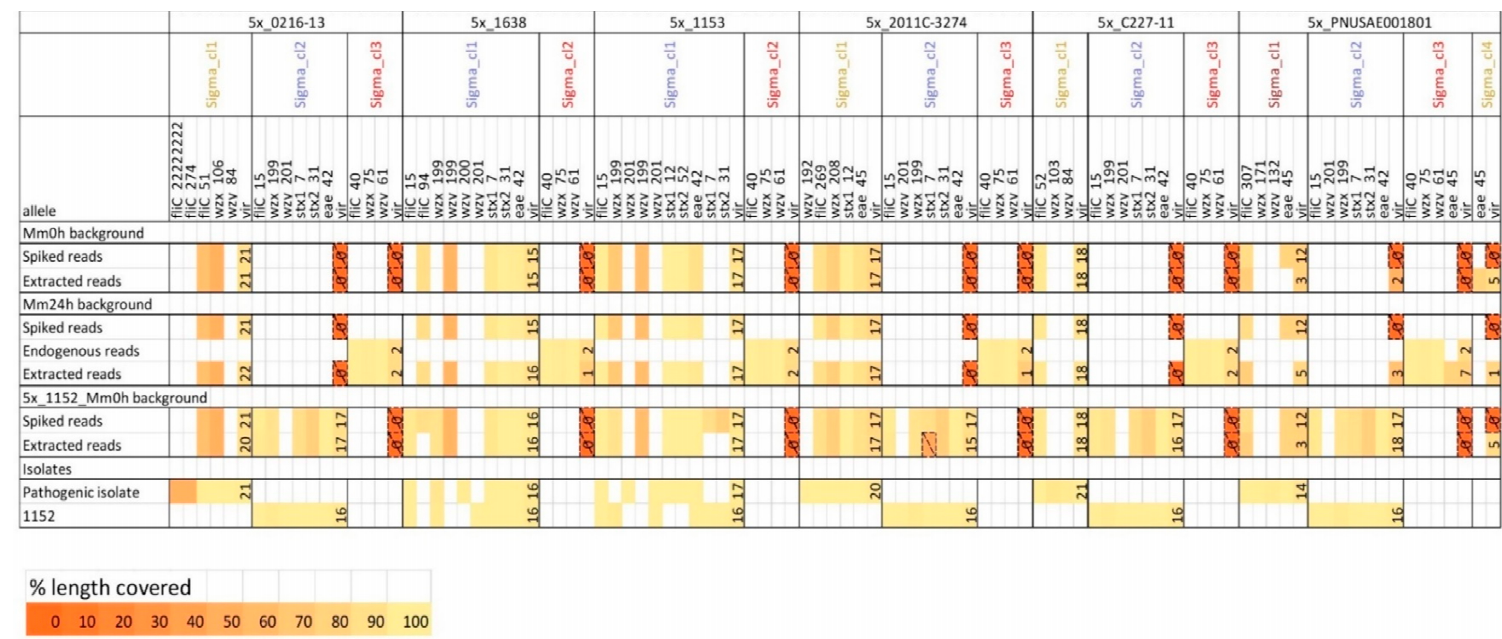
Figure 6. Strain-level analysis of in silico spiked metagenomic samples containing different pathogenic E. coli strains: gene detection. Reads from different pathogenic E. coli isolates (Table 1) were down-sampled to a coverage of ~5× (spiked reads) and in silico spiked into three metagenomic backgrounds: the non-enriched minced meat sample containing no endogenous E. coli strains (Mm0h background), the enriched minced meat sample containing one more prevalent (endogenous reads) and one negligible endogenous E. coli strain according to Sigma (the latter strain contained no virulence or serotyping genes and is therefore omitted) (Mm24h background), and an the non-enriched minced meat sample that has been previously in silico spiked with reads of a pathogenic E. coli isolate TIAC1152 (spiked reads, Sigma_cl2) at a coverage of 5× (1152_Mm0h background). The reads attributed to different Sigma clusters and thus presumably belonging to the different strains were extracted from the resulting in silico spiked metagenomic samples (extracted reads), and gene detection of the O- and H-type serotyping genes, STEC-specific virulence genes ( stx and eae ) and remaining virulence genes (vir) was performed. For the latter, only the total number of detected genes is shown (see Figure S6 for more details). The detected genes are grouped according to the Sigma clusters, in which the corresponding reads were retrieved. The line “endogenous reads” in the Mm24h background shows the genes observed in the main cluster extracted by Sigma from the unspiked Mm24h sample (Mm24h_Sigma_cl1). The last section of the table shows genes observed in the non-downsampled sequencing data of isolate TIAC1152 and the additional spiked pathogenic E. coli isolate (pathogenic isolate). Cell color represents the percentage of the allele length covered by reads (%). Only alleles covered for more than 50% at least once are included in the table. Thereby, alleles that are covered below 50% are encased with dashed lines, and are not considered during interpretation of the results.